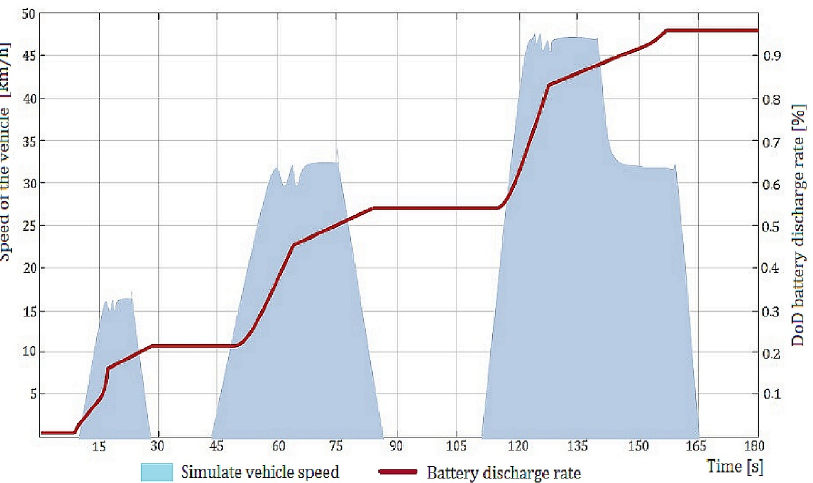
Figure 15. Plot of the battery discharge rate and speed of an electric car for a multi-valued logic tree with the floor layout of decision variables of: X 5 , X 2 , X 1 , X 4 , X 3 .